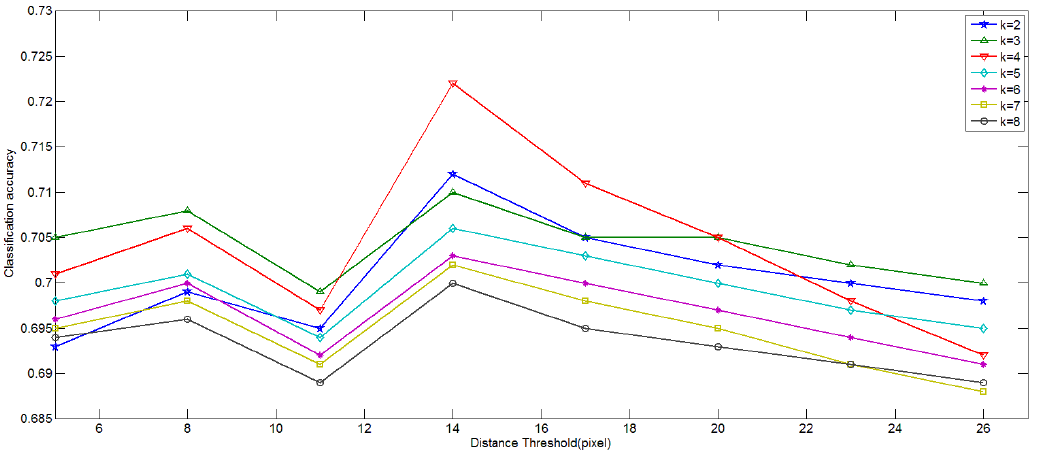
Figure 17. Classification accuracy with different distance thresholds and number of clusters over WHU-RS dataset.